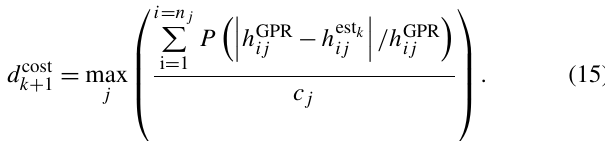
Figure 7. Glacier de la Plaine Morte model misfit h true − h est k after selected stages of the experimental design procedure using observed data (see also vertical dashed lines in Fig. 5). The selected GPR profiles are superimposed with green